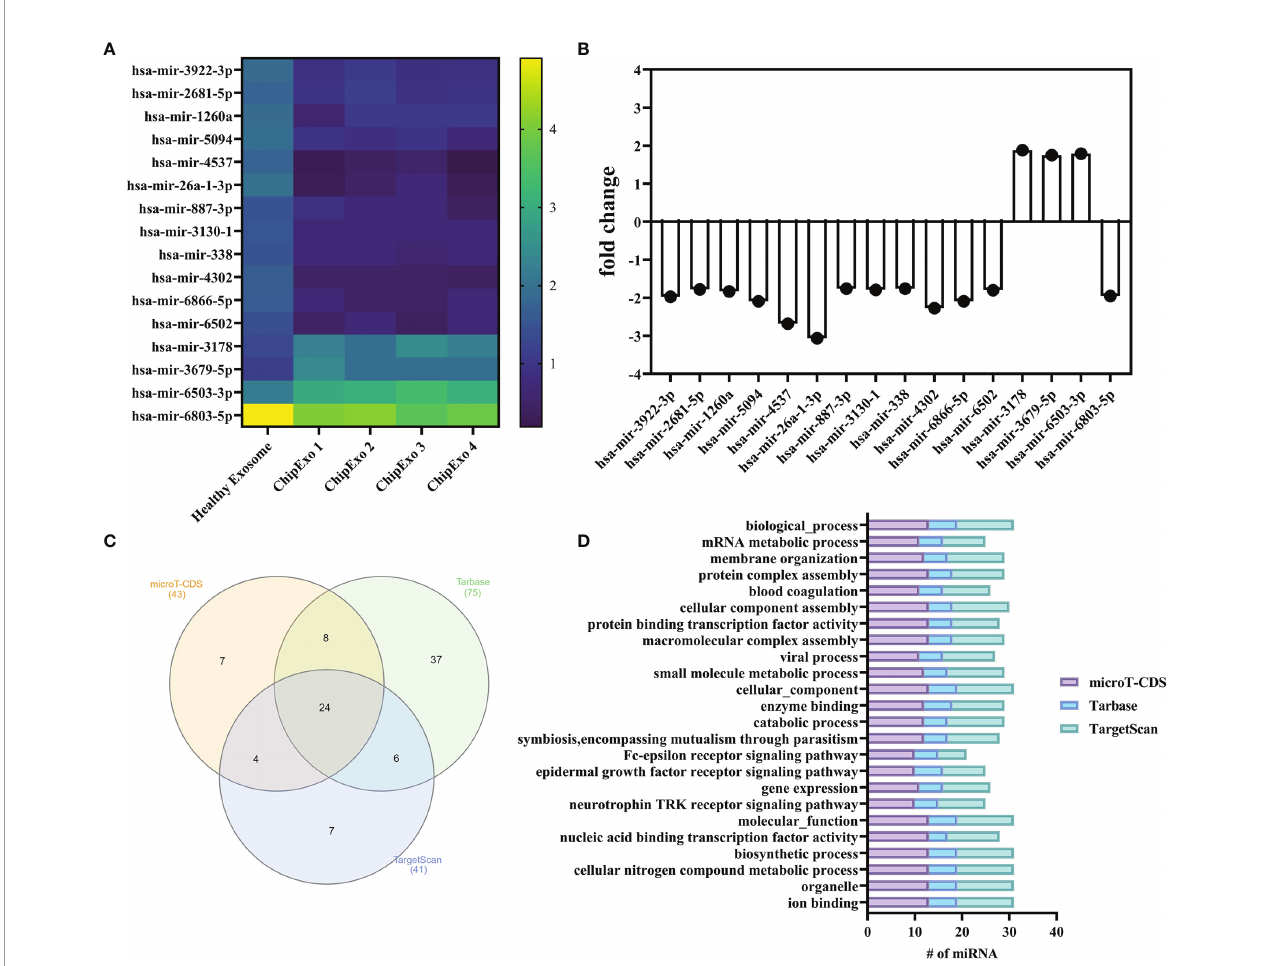
FIGURE 2 | miRNA analysis of ChipEXOs. (A) Heatmap demonstration of miRNA signals from two different sources of ChipEXOs and healthy-EXOs. (B) Enrichment and depletion of different miRNAs between the ChipEXO and healthy-EXO samples. (C) Venn diagram of GO pathways from three different databases (microT-CDS, TarBase, and TargetScan) of miRNAs. (D) GO pathway graph of miRNA found in all three